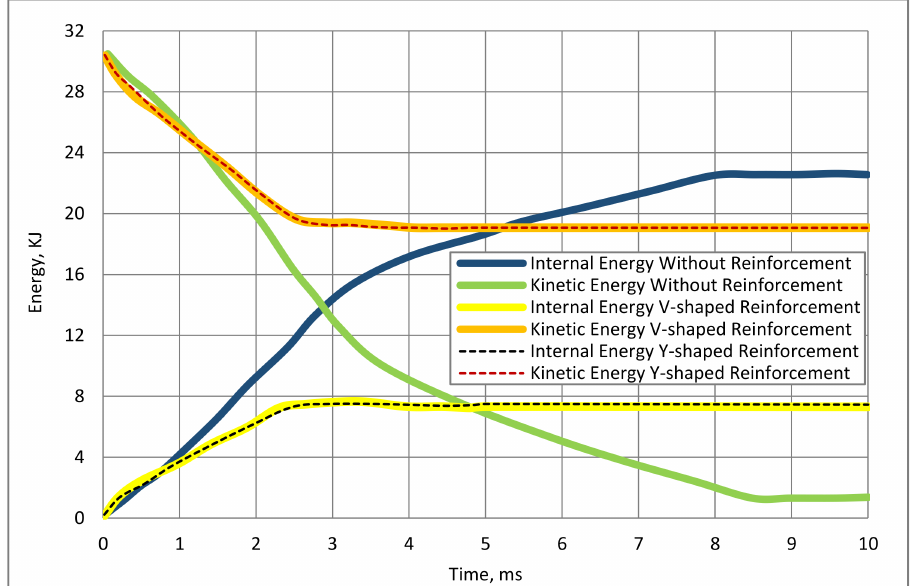
Figure 9. Energy conversion data during bird strikes.